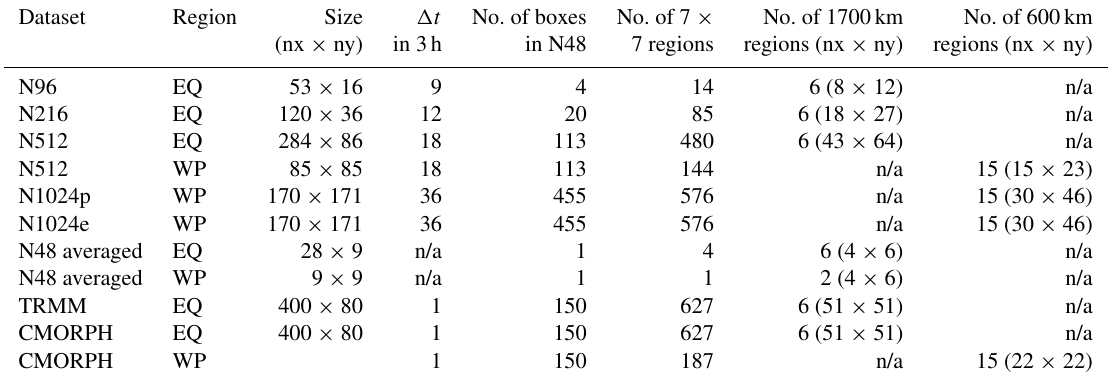
Table 2. For each MetUM-GA6 resolution, as well as TRMM and CMORPH: the analysis region used; the dimensions of each region in native grid boxes; the number of model time steps in 3h; the number of native grid boxes in an N48 grid box (rounded to the nearest whole grid box); the number of 7 × 7 native grid box regions in the analysis domain; and the number of “equal-area” 1700 and 600km regions in the analysis domain, with the dimensions of the regions (in native grid boxes) shown in parentheses. Dataset Region Size No. of